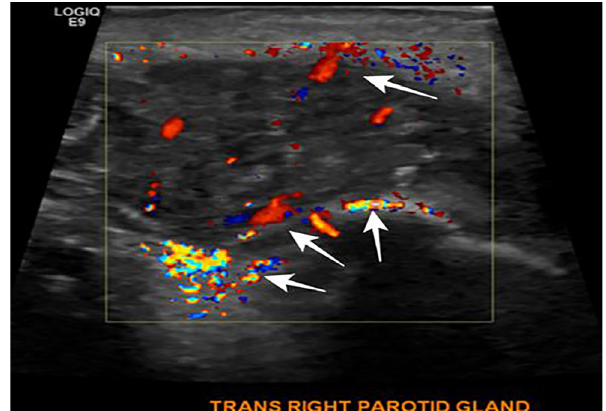
Image 2. Parotid point-of-care ultrasound: swollen right-side parotid gland (solid white arrow) compared to the left-side parotid gland (dotted white arrow).